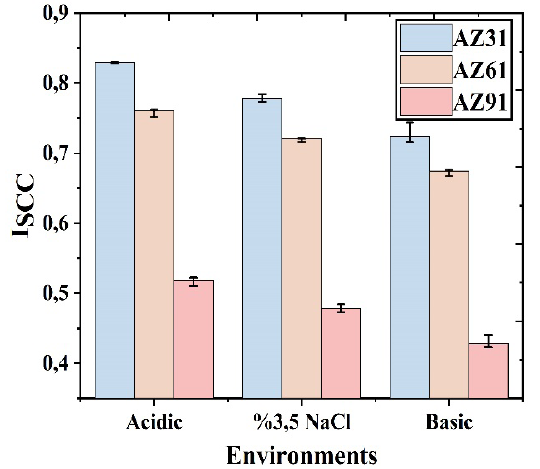
Figure 3: Stress corrosion indexes of AZ31, AZ61 and AZ91 Mg alloys in different